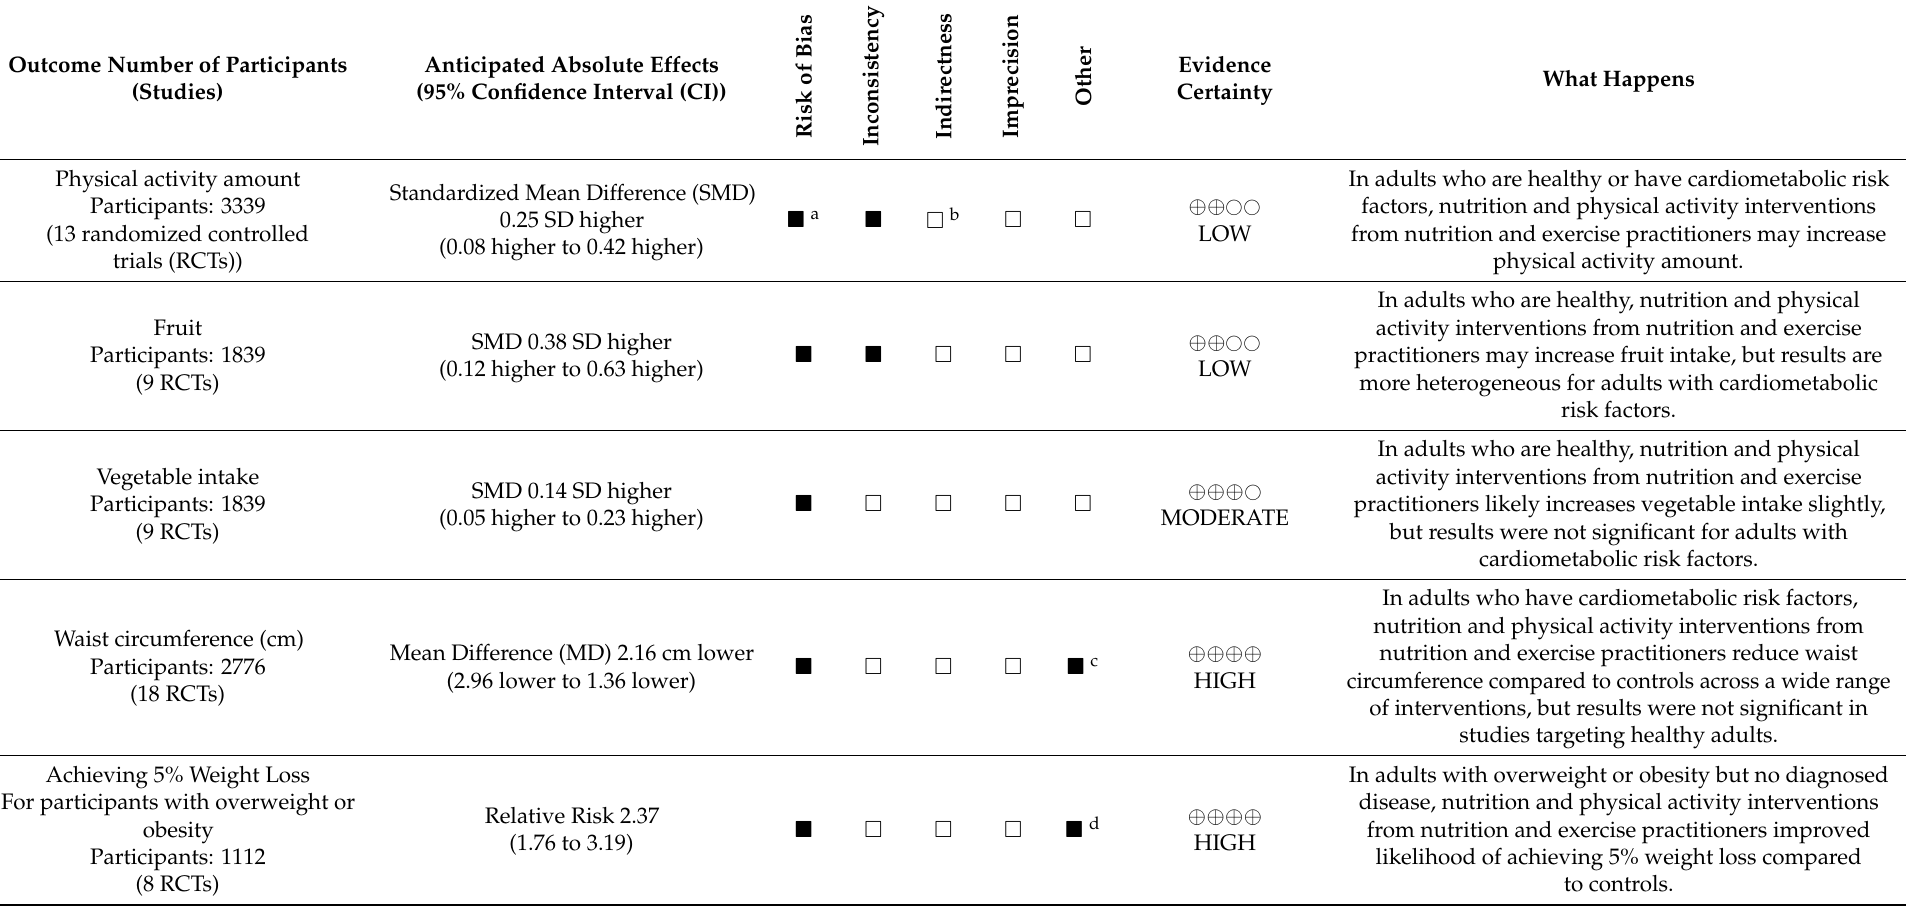
Table 4. Summary of findings describing effect of nutrition and physical activity interventions provided by nutrition and exercise practitioners for the general